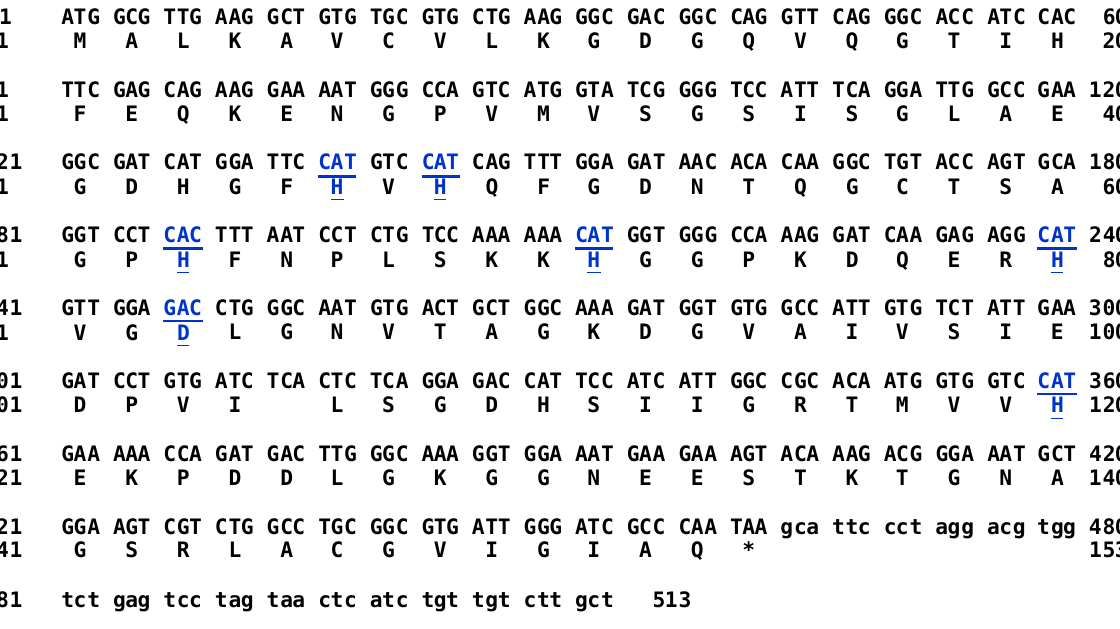
Figure 2. The nucleotide sequence and the deduced amino acids of the cloned cSOD1 . The sequences were submitted to NCBI GenBank (accession number JF758876 and AEF32527, respectively). The metal binding residues and its corresponding codons are